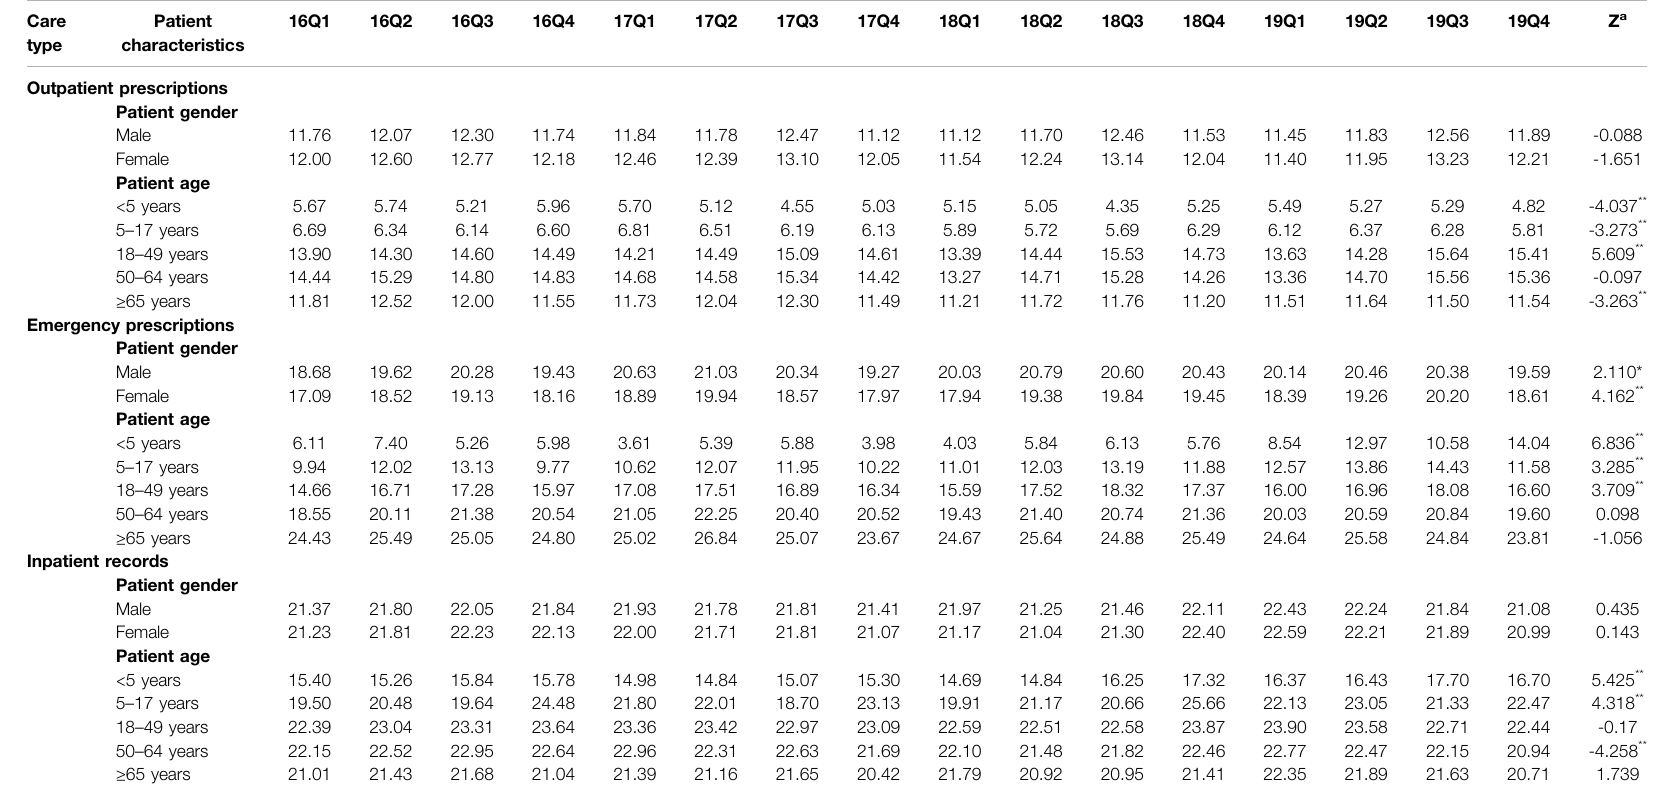
TABLE 6 | Changes in proportion of prescribed with muti-antibiotics by patient characteristics, 2016 – 19. prescribed with parenteral antibiotics (c). Care Patient type characteristics Outpatient prescriptions Patient gender